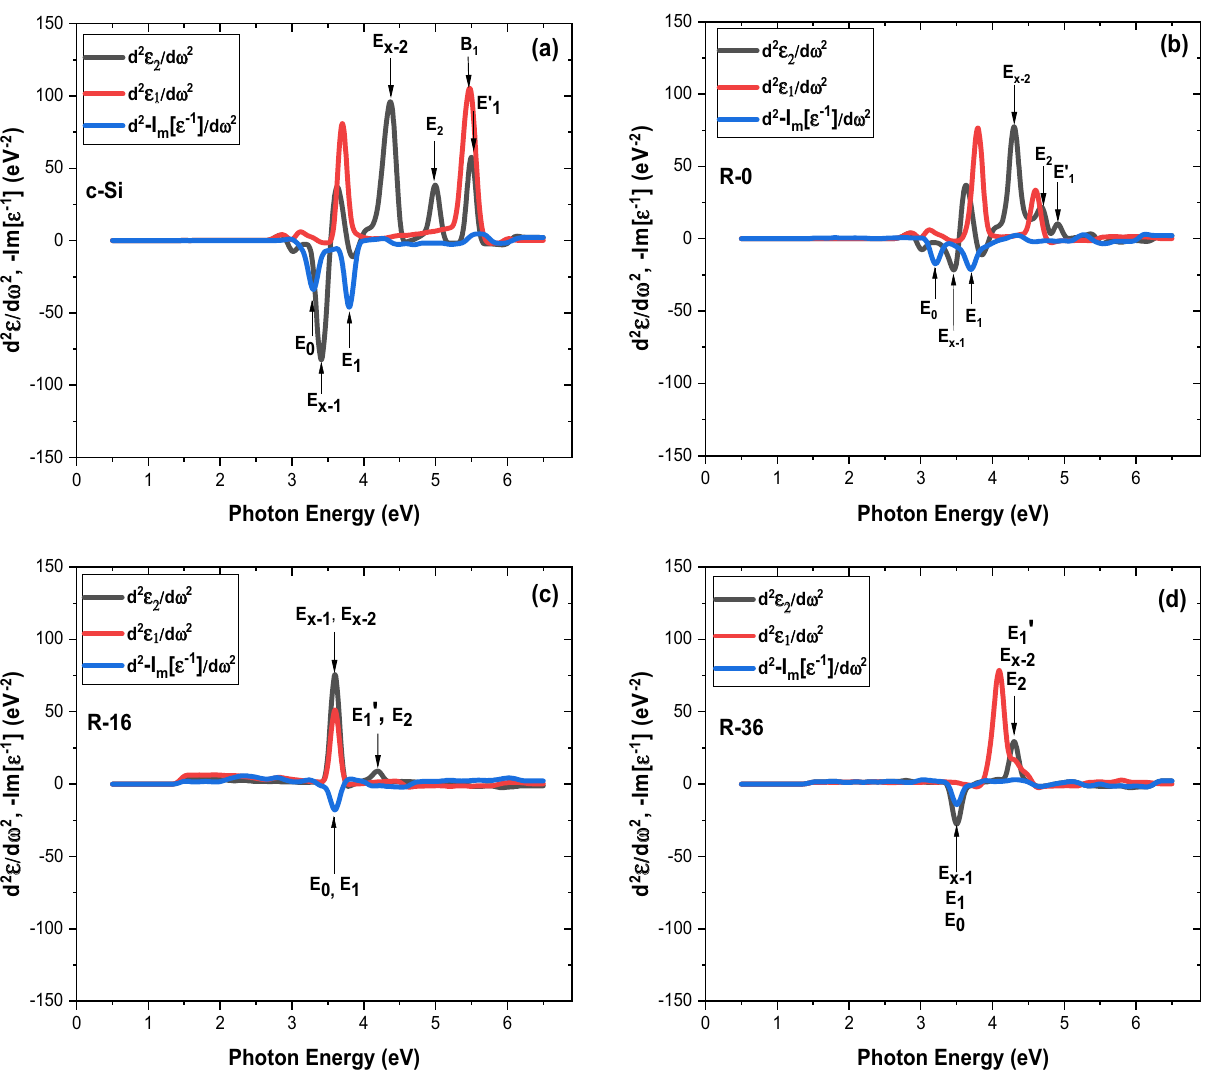
Figure 4. Fits to the second derivatives of the real (blue line) and imaginary (red line) parts complex dielectric function, include loss function of ( a ) c-Si, ( b ) R-0, ( c ) R-16, and ( d )